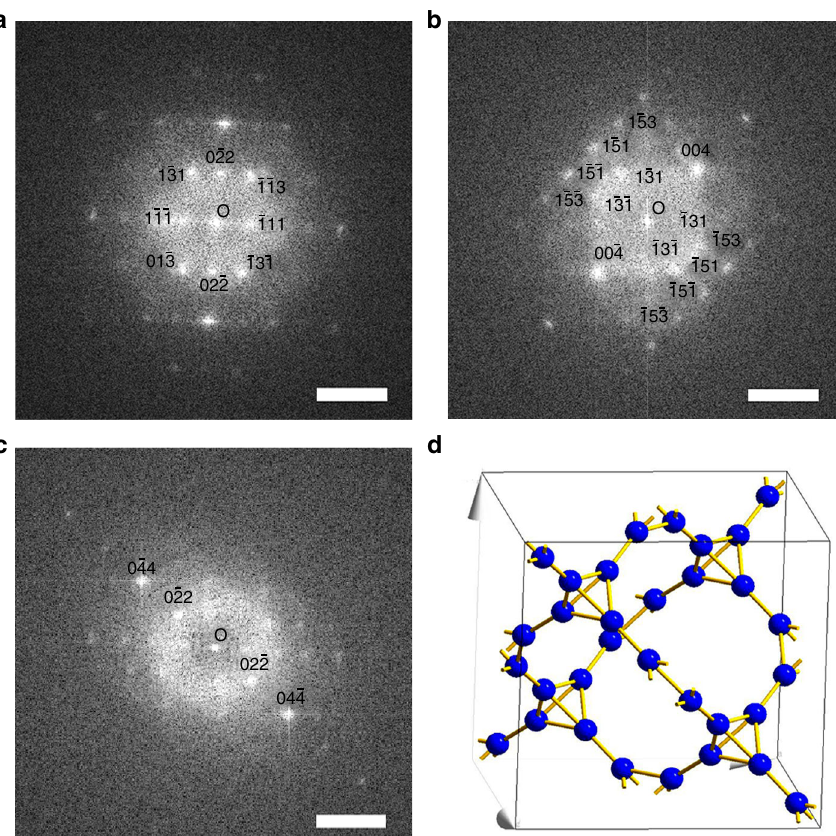
Fig. 2 FFT patterns and structural model of a T-carbon nanowire. FFT patterns with a zone axis of [2, 1, 1], b zone axis between [3, 1, 0] and [5, 1, 0] with an angle from a of 27°, and c zone axis close to [5, 1, 1] with an angle from a of 18° and an angle from b of 10° ( scale bar = 5 nm − 1 ). d Structural model of T- carbon (Fd3m, lattice constant = 7.80